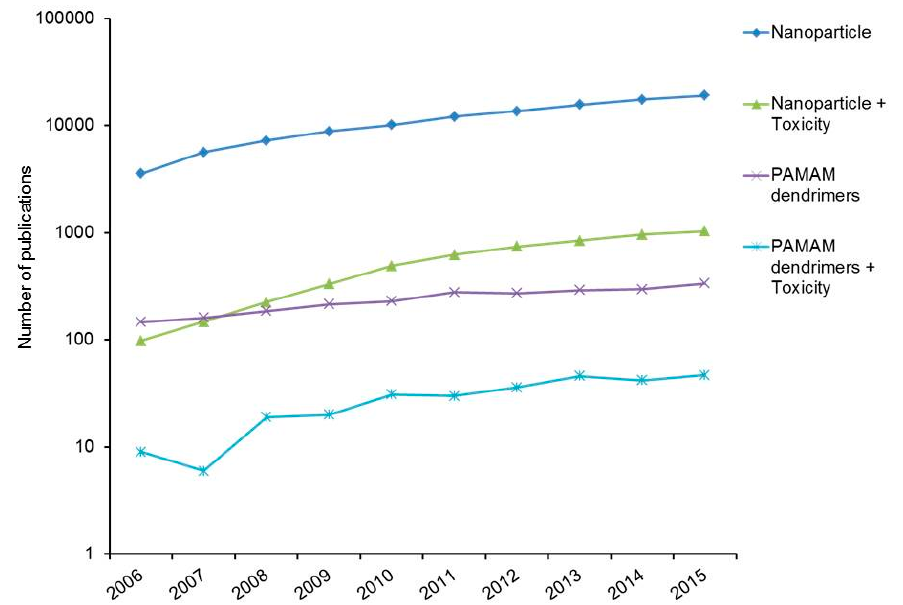
Figure 1. Number of publication on nanoparticle, nanoparticle toxicity, PAMAM dendrimers, and PAMAM dendrimer toxicity. Data acquired from the Web of Science database.